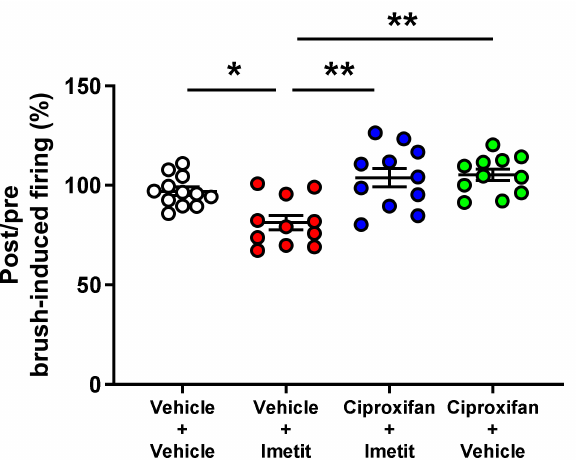
Figure 2. Ciproxifan (H 3 R antagonist) inhibits the suppressive effect of imetit on neuronal firing of the peripheral nerve. The genital area was first stimulated with a brush, following which evoked firing was evaluated. The post and pre-administration ratios are displayed. Data are presented as the mean ± S.E.M. * p < 0.05 and ** p < 0.01 analyzed using Tukey’s multiple comparison test (n =